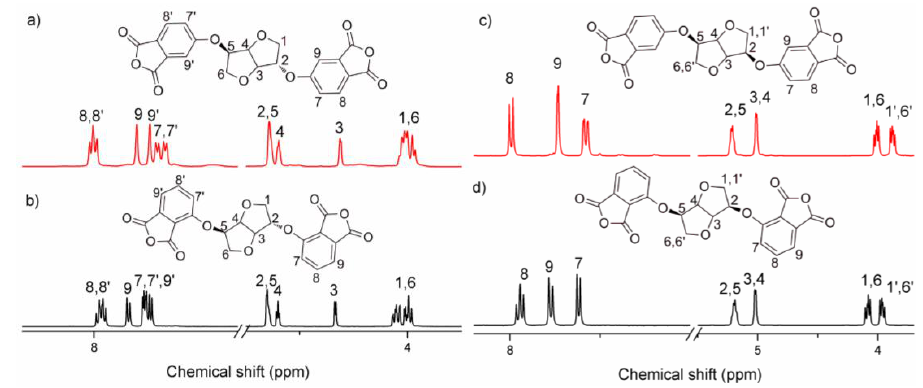
Figure 1. 1 H NMR spectra of isohexides-derived isomeric dianhydrides in DMSO- d 6 . ( a ): 4,4′-ISDPA; ( b ): 3,3′-ISDPA; ( c ): 4,4′-IMDPA; and ( d ): 3,3′-IMDPA.